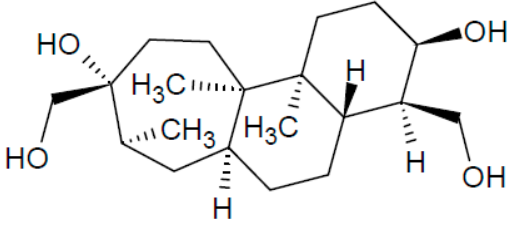
Figure 3. Aphidicolin structure.